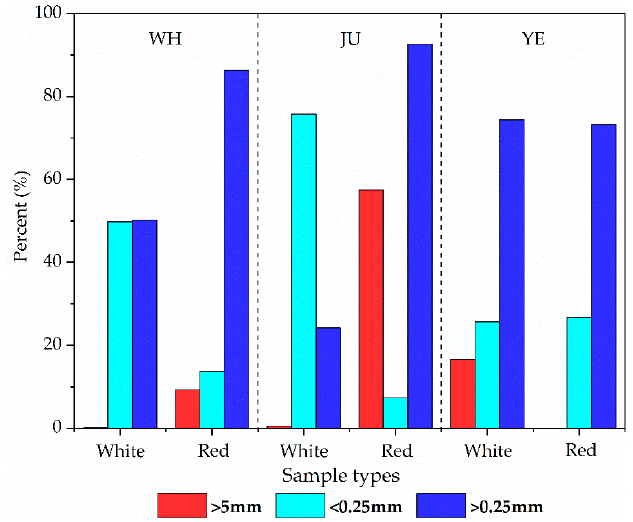
Figure 9. The aggregates content of red matrix and white vein. In this figure, “White” represents white vein, and “Red” represents red matrix.